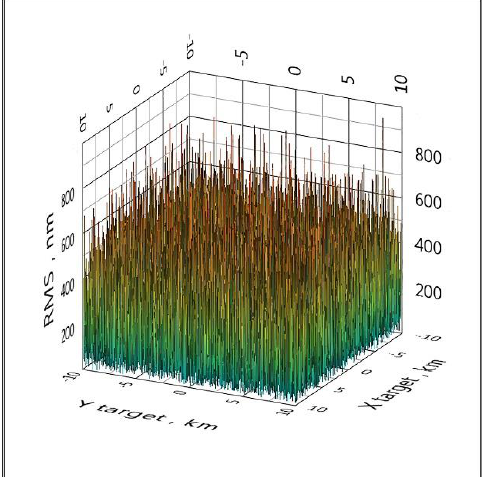
Figure 9. The distribution of the RMS coordinate (1 nanometer (nm) = 10 −9 m) estimate over the area when Gaussian noise is added to the TDoA values with a standard deviation of 0 ps (GPS).